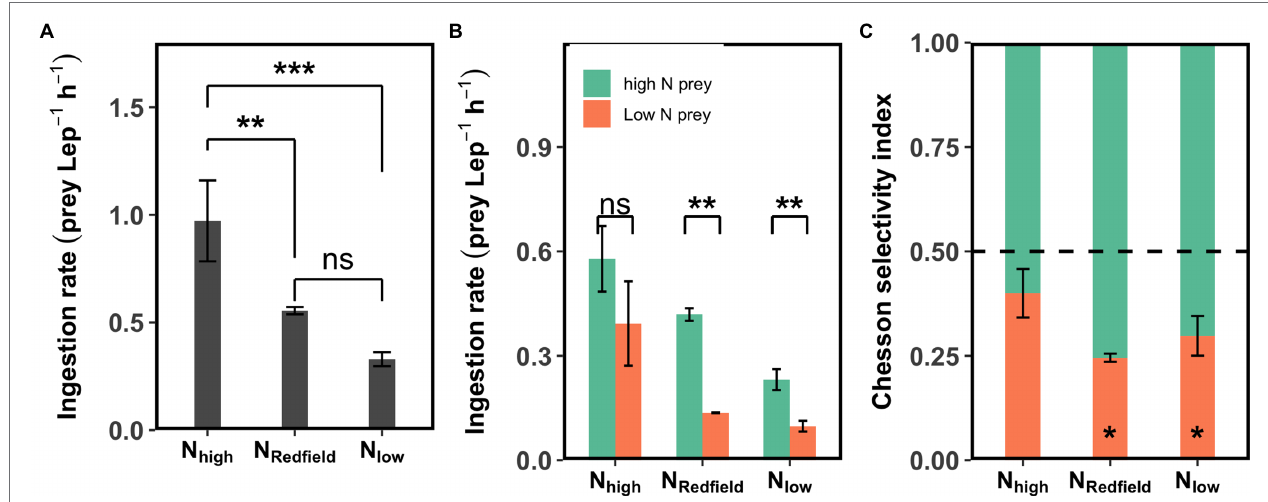
Supplementary Figure S4 ). The total ingestion rate of Lepidodinium sp. was affected by both temperature (two-way ANOVA, p < 0.001) and environmental inorganic nutrient conditions (two-way ANOVA, p < 0.01, Table 3 ). Increasing temperature not only increased the total ingestion rate of the Lepidodinium sp. but also exacerbated their feeding selectivity ( Figures 3, 4 ). Under N Redfield and N low conditions, the ingestion rate of Lepidodinium sp. on the low-N prey remained unchanged at the three temperatures (one-way ANOVA, p > 0.05, Figure 3 ; Supplementary Figure S6 ). Nevertheless, the ingestion rate on high-N prey significantly increased when temperature increased from 28 ° C to 31 ° C under N Redfiled and N low conditions (Tukey HSD test; p < 0.05; Figure 3 ; Supplementary Figure S6 ). Therefore, the Chesson’s selectivity index α increased significantly from 0.64 ± 0.1 to 0.83 ± 0.02 under N Redfiled condition (Tukey HSD test; p < 0.0001; Figure 4 ). While rising temperature did not significantly affect prey selectivity of Lepidodinium sp. under N low condition because the selectivity index kept high (one-way ANOVA, p > 0.05; Figure 4 ). The Chesson selectivity index α was 0.76 ± 0.08 and 0.78 ± 0.03 under N low conditions at 28 ° C and 31 ° C, respectively ( Figure 4 ). Under the N high condition, Lepidodinium sp. increased their ingestion on both high-N and low-N prey when the temperature increased ( Figure 3 ; Supplementary Figure S6 ). However, the increase in the ingestion rate on high-N prey was more significant, resulting in selective feeding and a slight increase in the Chesson’s selectivity index α at 31 ° C (0.58 ± 0.06; Figure 4 ). The prey selectivity of Lepidodinium sp. was significantly regulated by both temperature (two-way ANOVA, p = 0.012 < 0.05) and pre-conditions with different medium N:P ratios (two-way ANOVA, p < 0.0001; Table 3 ).